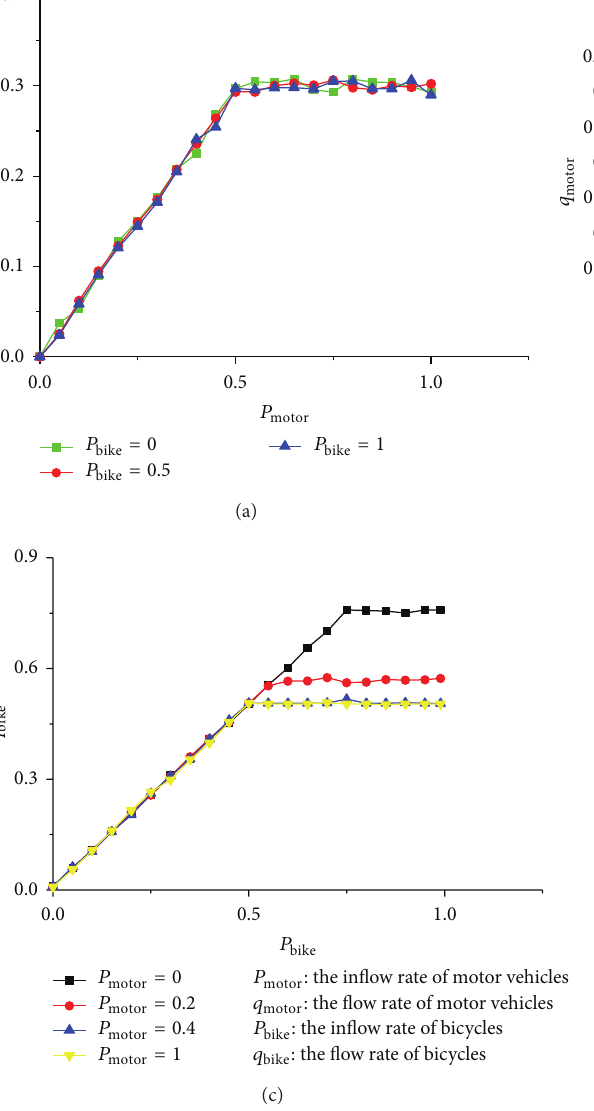
Figure 6: The simulation results of Type III bus